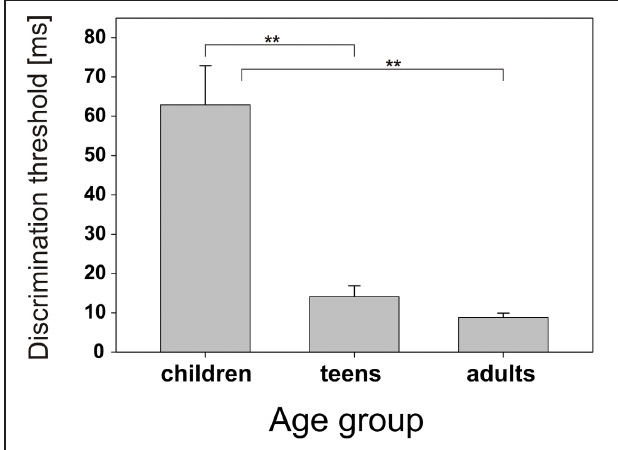
FIGURE 1 | Behavioral discrimination thresholds. Group means and standard error for interaural duration discrimination for children, teens, and